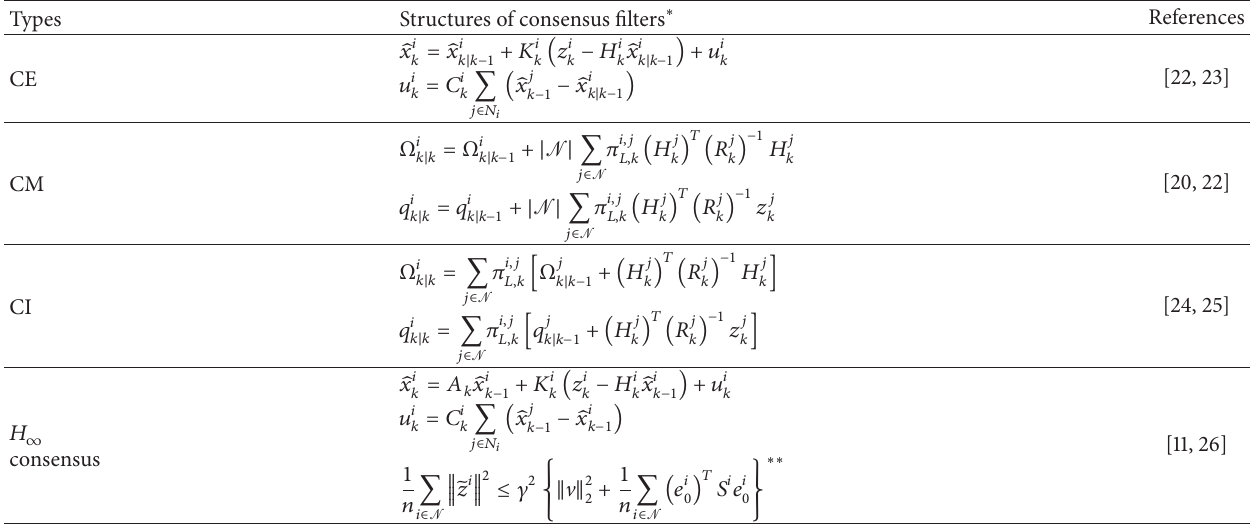
Table 2: The mechanisms of four consensus filtering